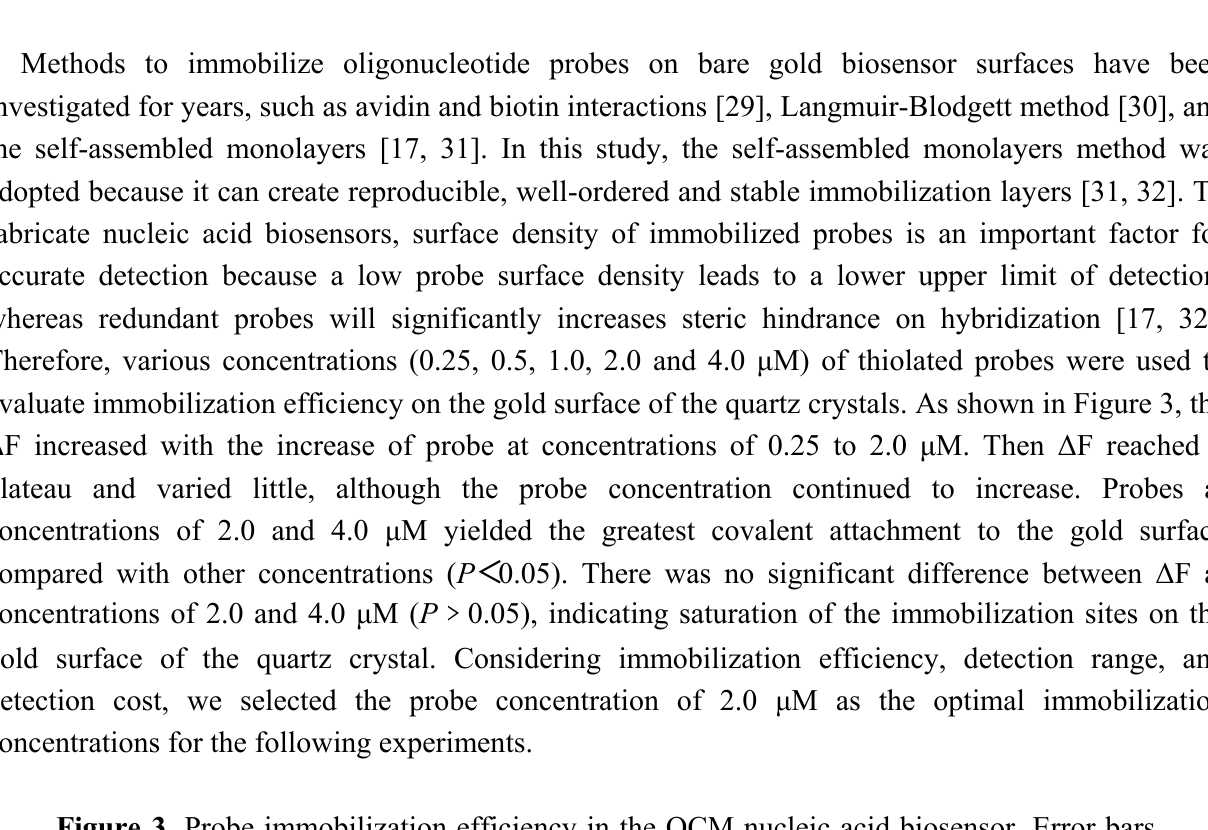
Figure 3. Probe immobilization efficiency in the QCM nucleic acid biosensor. Error bars indicate the standard deviation